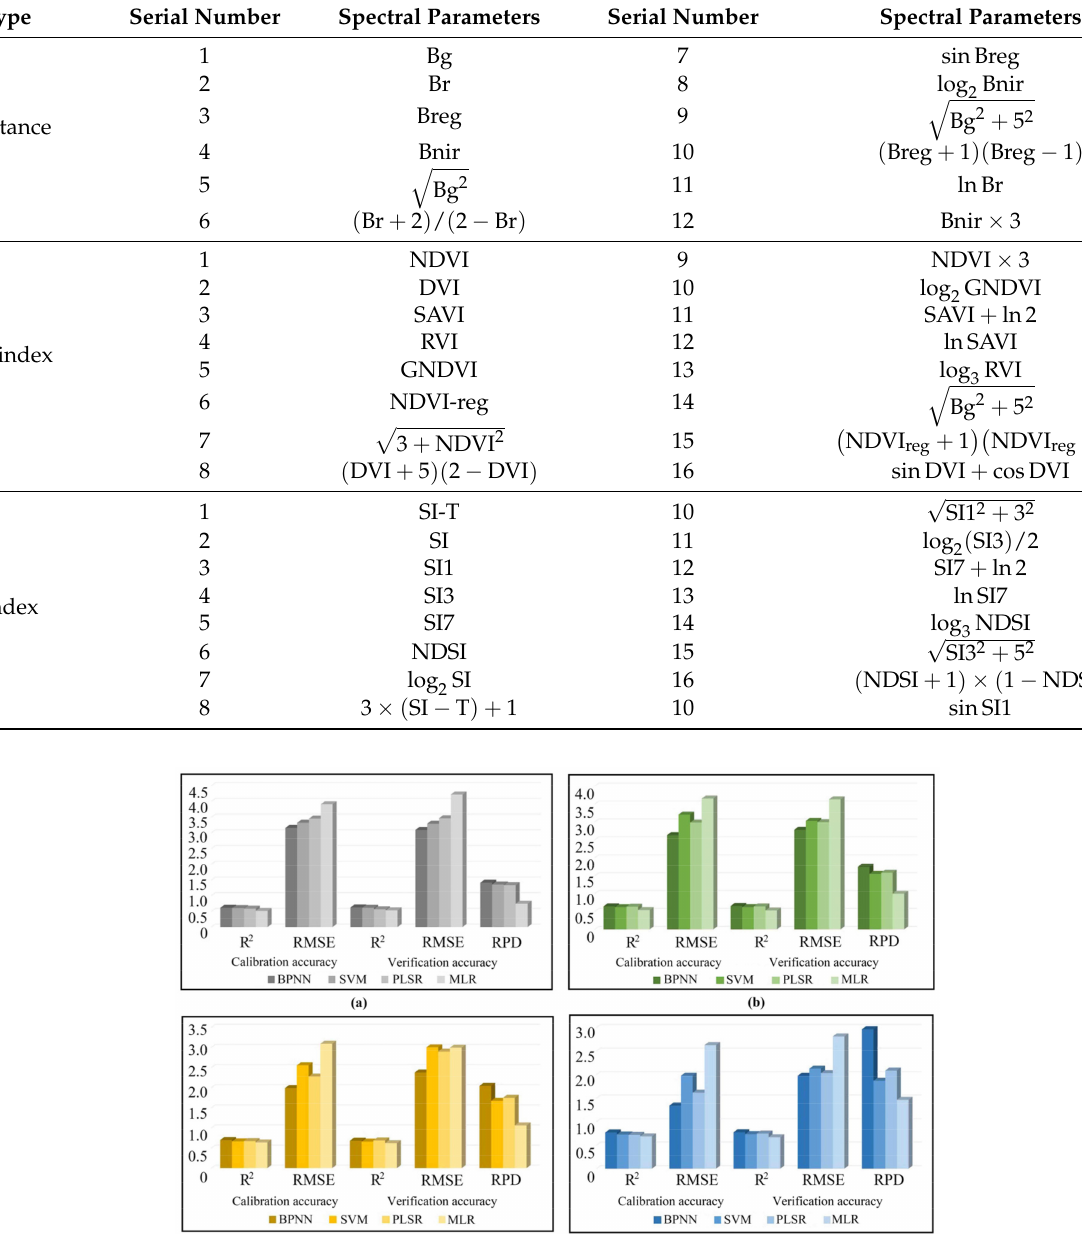
Table 5. Spectral parameters of the band reflectance, vegetation index, and salinity estimation model.